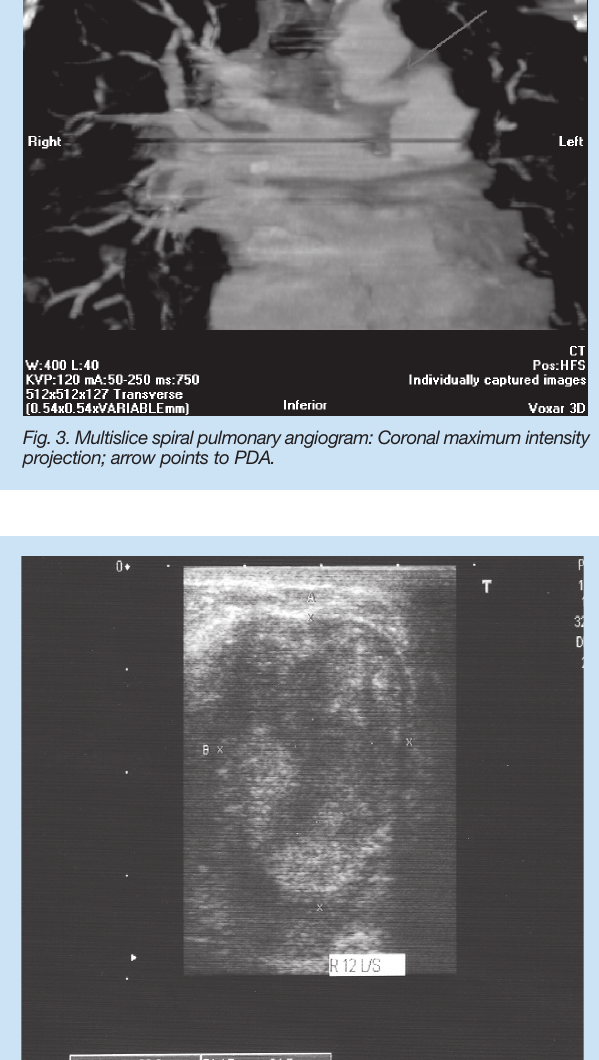
Incidental.indd 57 8/17/09 3:02:18